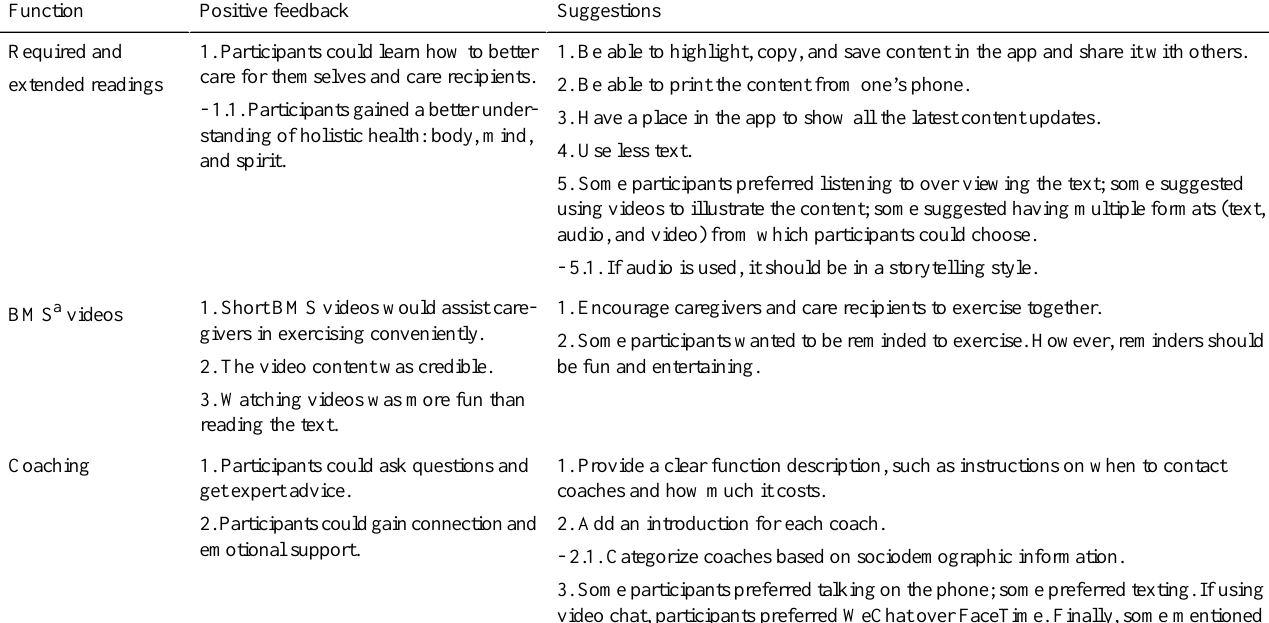
Table 1. Feedback for app